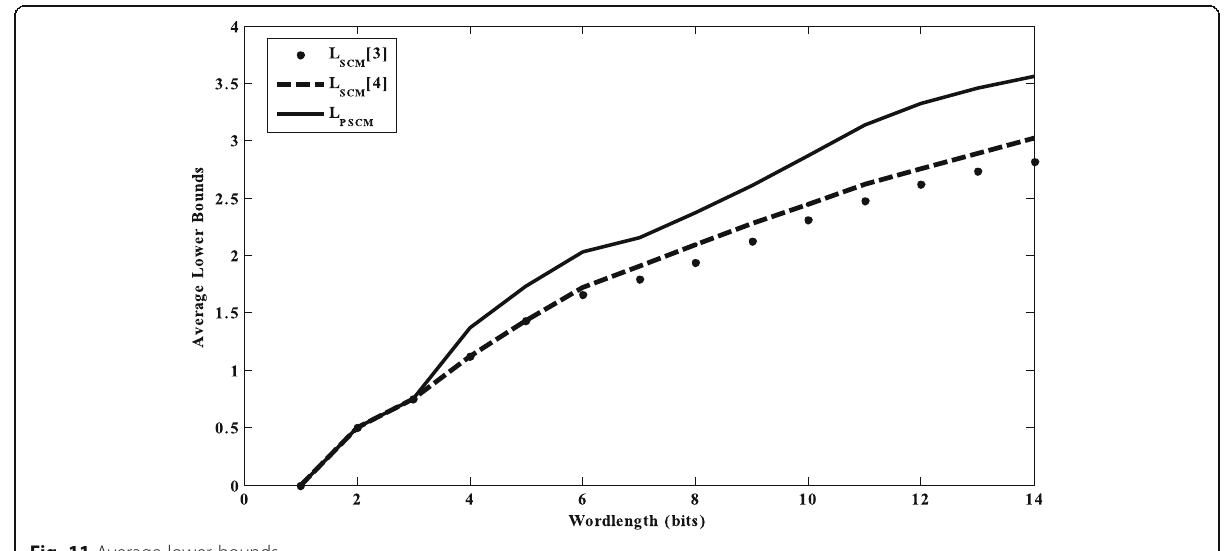
Fig. 11 Average lower bounds